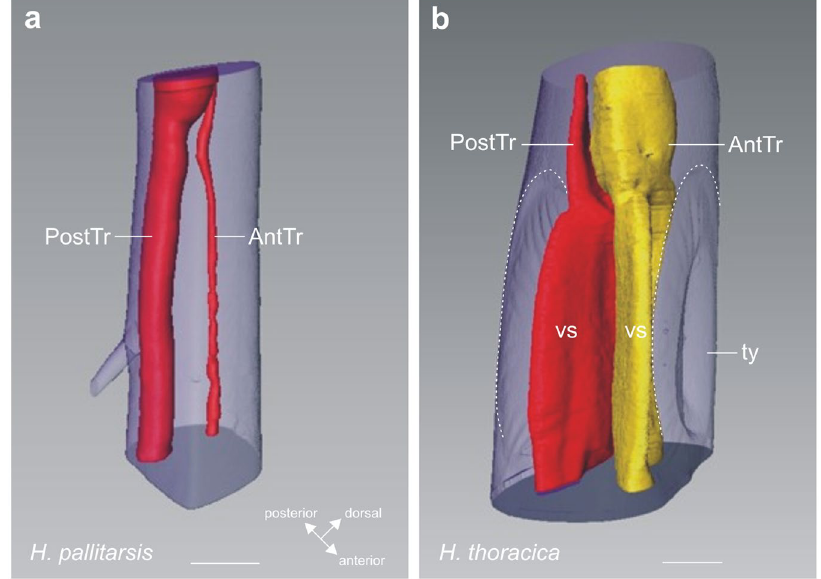
Figure 3. Tracheal system in the foreleg tibia reconstructed from μ CT scans. Tibial trachea in ( a ) ground weta H. pallitarsis and ( b ) the tree weta H. thoracica . An anterior (AntTr) and posterior tibia (PostTr) run in the tibia, which are enlarged in the tree weta between the tympanal membranes (ty; hatched lines) as acoustic vesicles (vs). Abbreviations: at, anterior trachea; pt, posterior trachea; ty, tympanum; vs, vesicles. Scale: ( a ) = 200 µ m, ( b ) = 500 µ m.